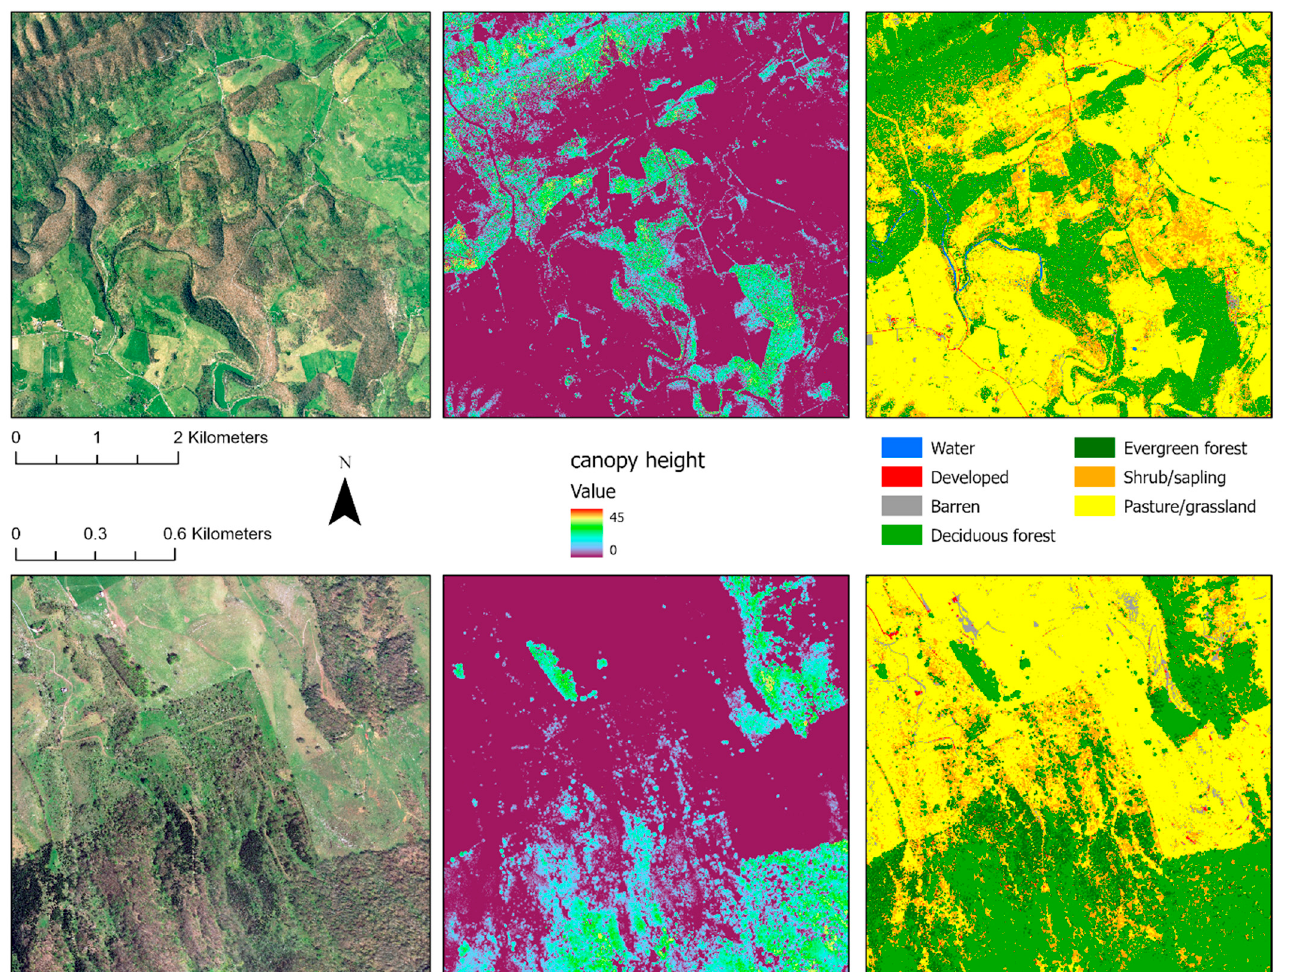
Figure 3. NAIP imagery ( left ), a LIDAR-derived canopy height model ( middle ), and our custom land cover classification ( right ) for two scenes in our study area, the top is a larger extent than the bottom.